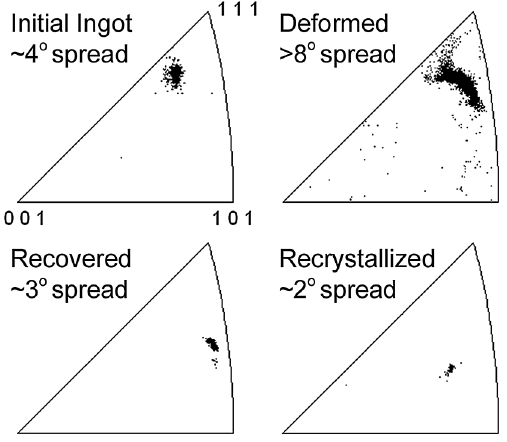
FIG. 9. Representative discrete inverse pole figures from OIM TM measurements from different specimens. The spread of crystal orientations is greatest after deformation, and signifi- cantly lower after heat treatments to cause recovery or recrystal-